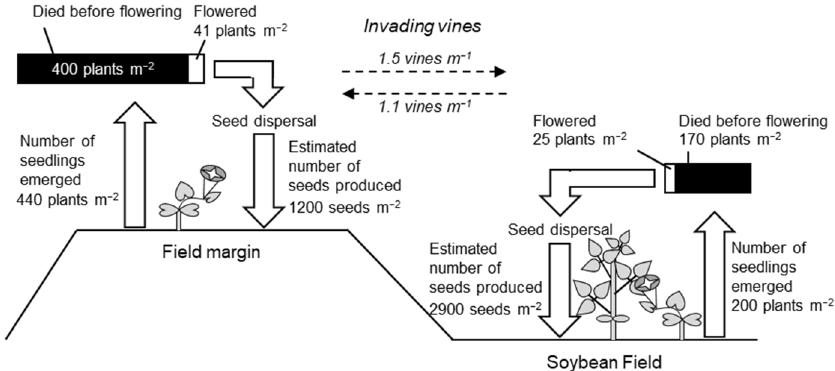
Figure 5. Population model of entireleaf morning glory in the field and margin of RBS-1 in 2017. The quantitative flow of the populations of entireleaf morning glory from the germination to seed dispersal in the field and their margins is indicated by arrows and values. The fate of the seedlings (successful flowering or death before flowering) is indicated by numbers in the white and black bars. The total number of flowering and dying plants differed from the total number of emerged plants because each value was rounded to two significant figures. Italics and dotted arrows indicate the number of invading vines and the direction of invasion, respectively. RBS-1 (rice–barley–soybean-1) in 2017 was selected because the number of plants that emerged was sufficient to illustrate a quantitative change in the